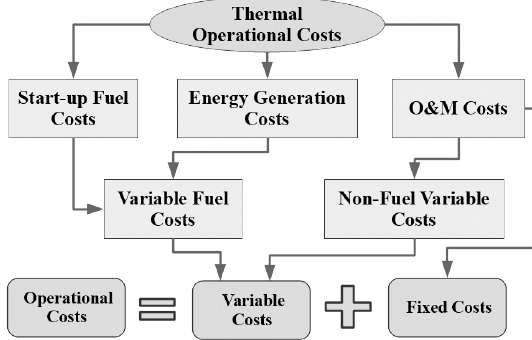
Figure 1. Detail of Thermal Operational Costs.